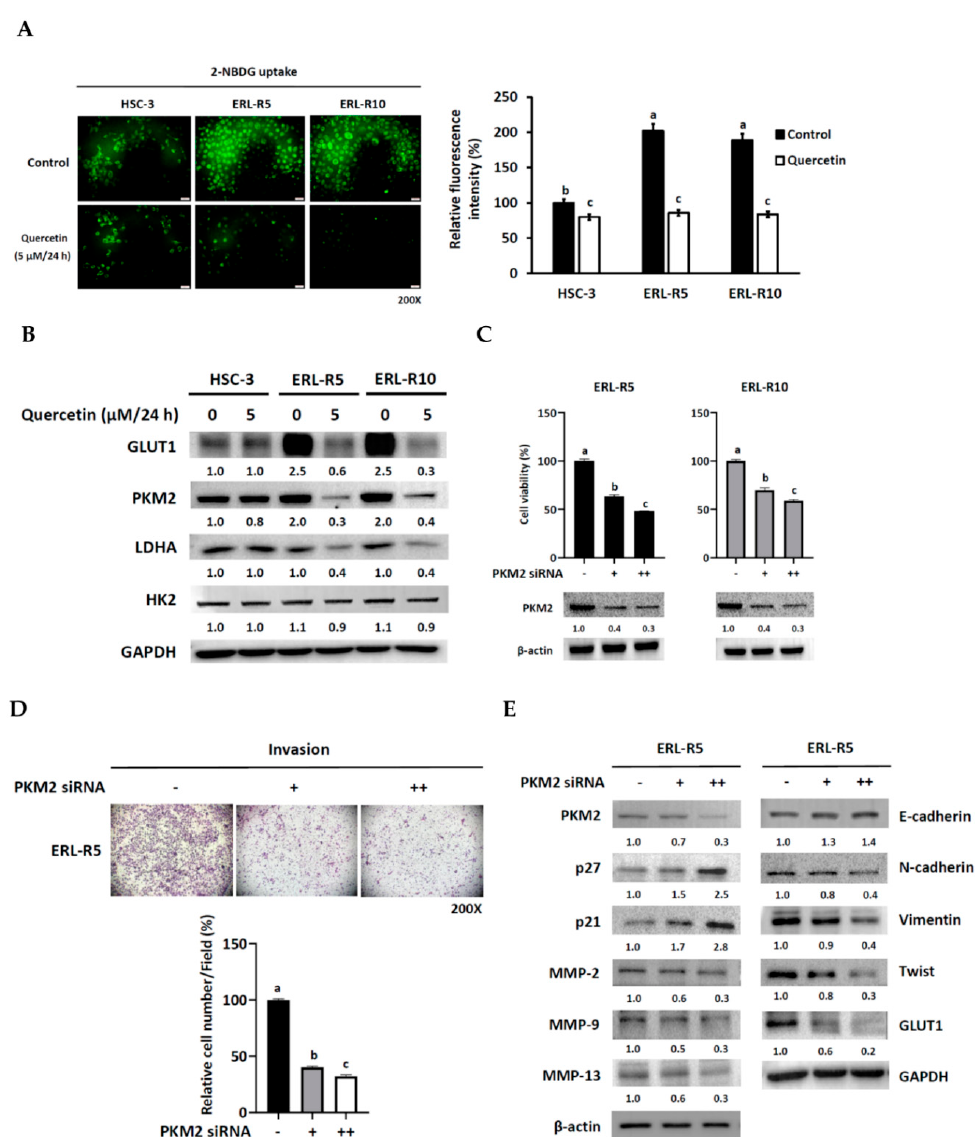
Figure 5. Quercetin modulates glucose utilization and PKM2 expression in erlotinib-resistant cells. ( A ) HSC-3, ERL-R5, and ERL-R10 cells (2 × 10 4 /24-well plate) were cultured in media containing quercetin (5 µ M) or not for 24 h after seeded, followed by low glucose media with 2-NBDG for 10 min. Photographs were taken by a fluorescent microscope, and quantified as relative fluorescence intensity to the control HSC-3 with no quercetin. ( B ) After 24 h of treatment with or without quercetin (5 µ M), cell lysates from HSC-3, ERL-R5, and ERL-R10 cells were collected and subjected to Western blotting for the detection of GLUT1, PKM2, HK2, and LDHA protein levels. GAPDH served as a loading control. ( C – E ) PKM2 knockdown mimics the quercetin effect. Erlotinib-resistant HSC-3 cells were transfected with PKM2 siRNA (0, 10, 20 µ M) for 24 h and then subjected to determination of ( C ) cell viability by an MTT assay, ( D ) invading capacity by a Matrigel invasion assay, and ( E ) their related protein levels by Western blot analysis. Values are mean ± SD, n = 3. abc Values with different letter differ significantly at indicated time point, p < 0.05.